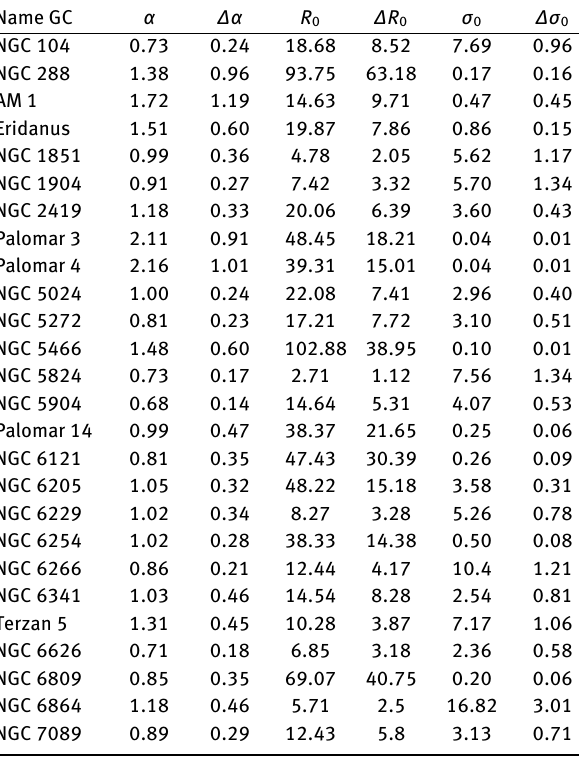
Table 1. The results of calculating the free parameters of the model by the χ 2 method for observational data Miocchi et al.